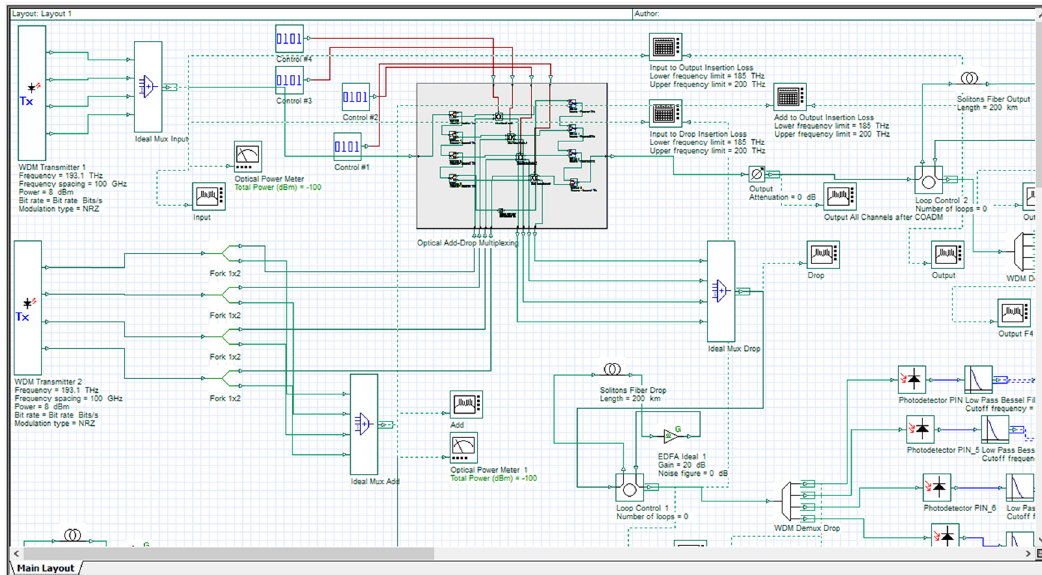
Figure 2: Demonstrate the four main stages for proposal